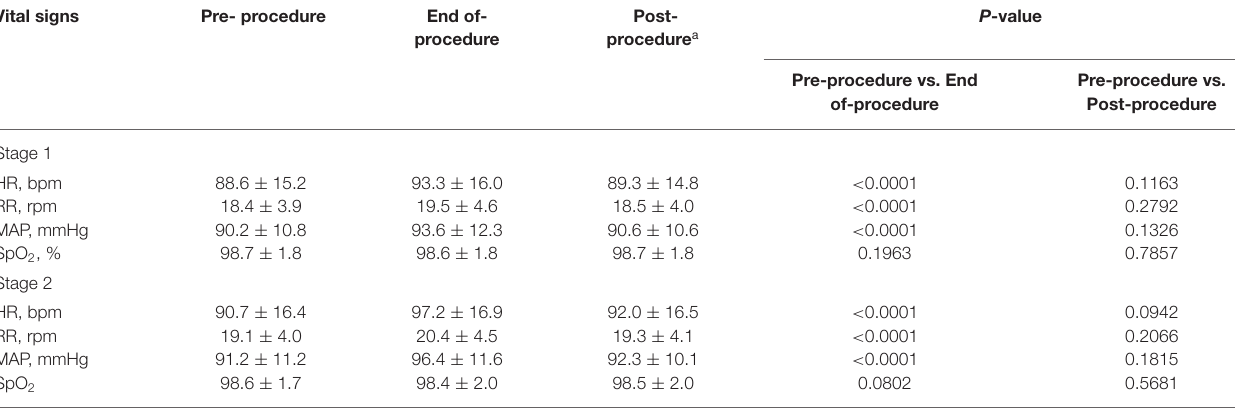
TABLE 4 | Vital signs monitored